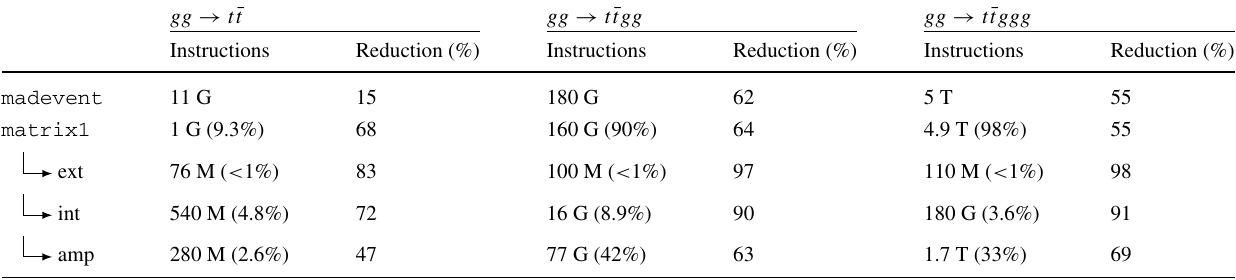
Table 2 The same as Table 1 but this time with helicity recycling enabled. We also present the percentage reduction between the two tables